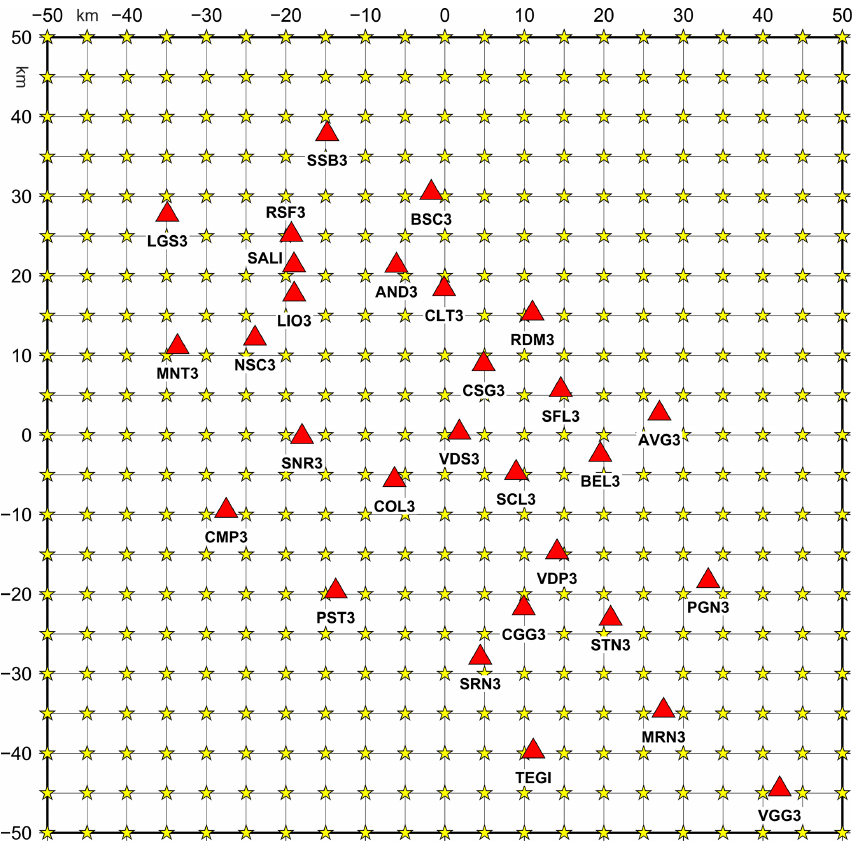
Figure 3. Regular grid of epicentres (yellow stars) used for simulating earthquakes. The area is 100km × 100km with 5km of spacing along both horizontal coordinates. The Irpinia Seismic Network (ISNet) is reported with red triangles.